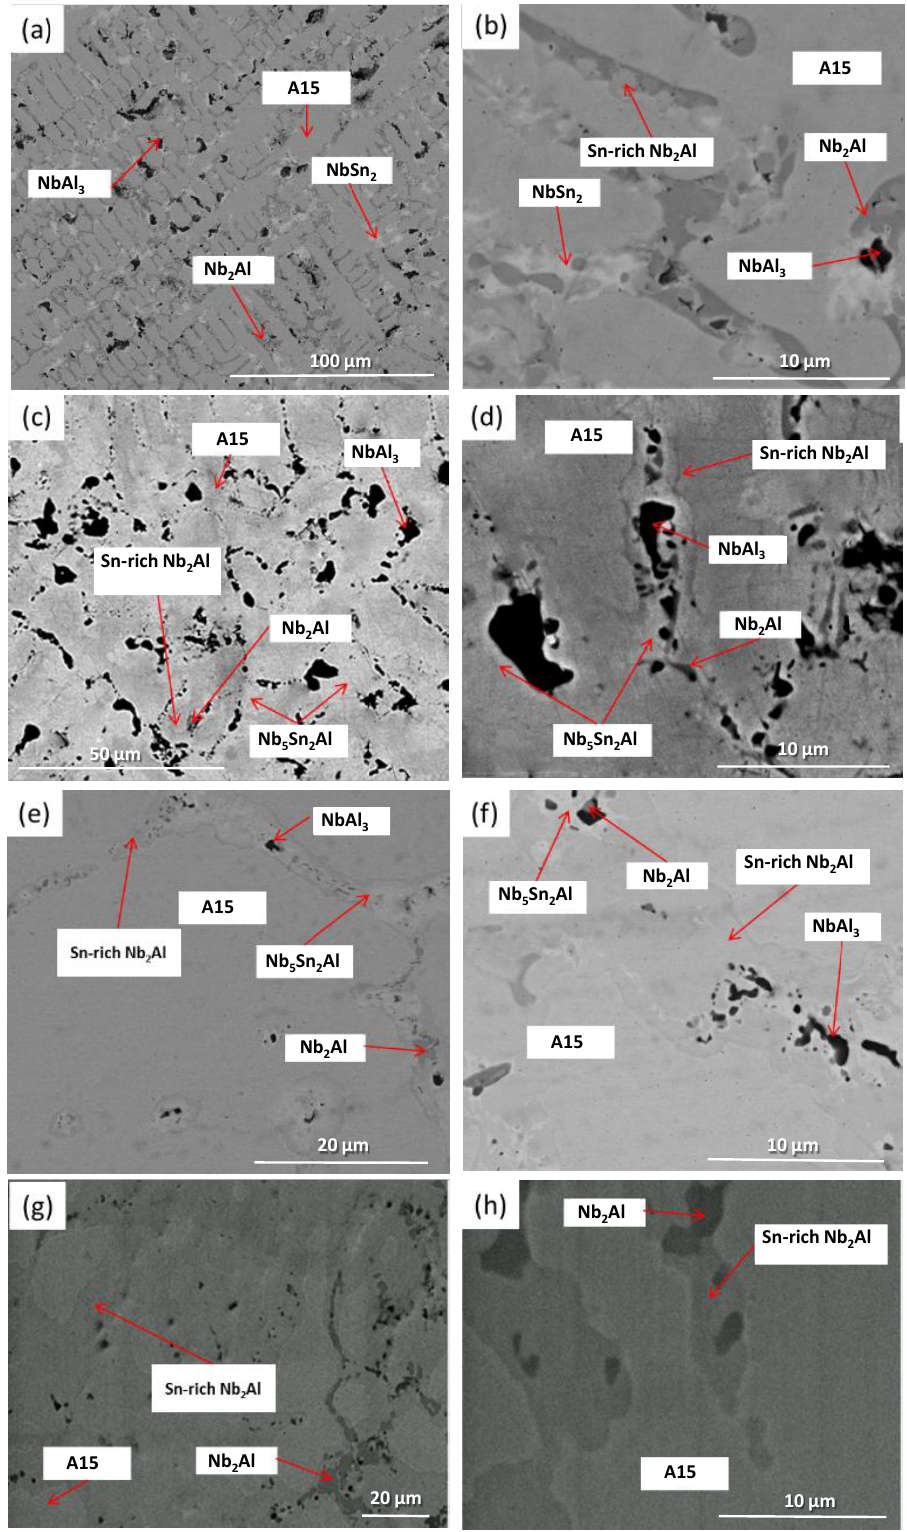
Figure 8. BSE images of ( a , b ) IP6-AC, ( c , d ) IP6-HT-900 °C/100 h, ( e , f ) IP6-HT-900 °C/200 h and ( g , h ) IP6-HT-1200 °C/100 h.